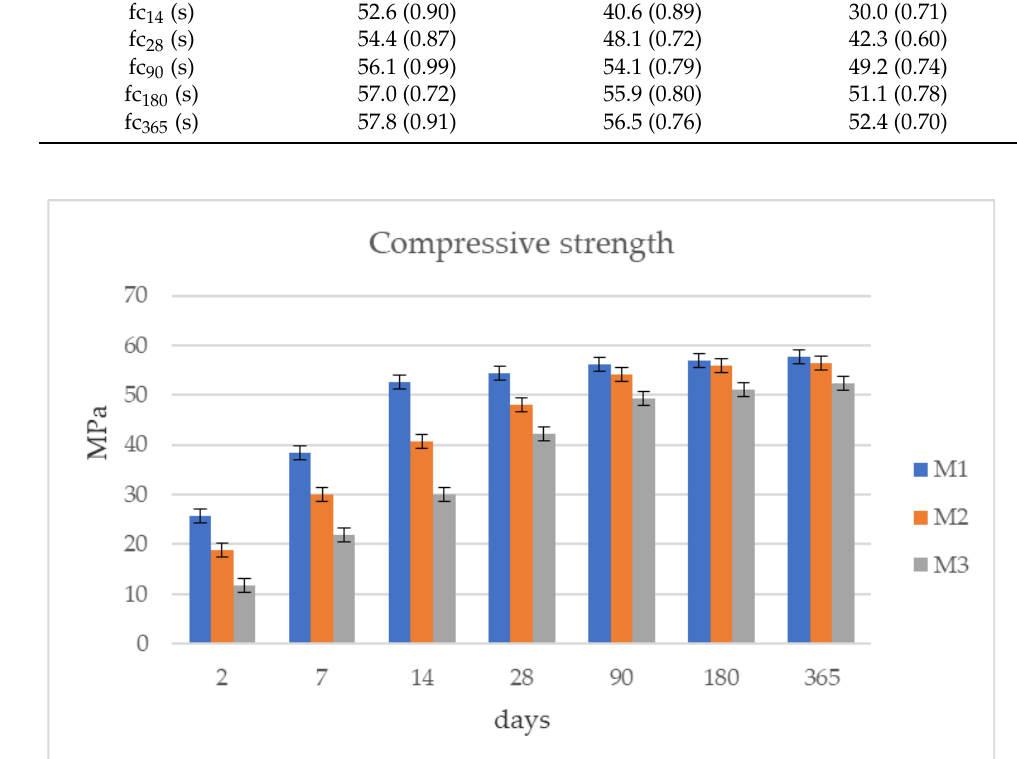
Figure 4. Compressive strength (MPa) of mortar mixtures.